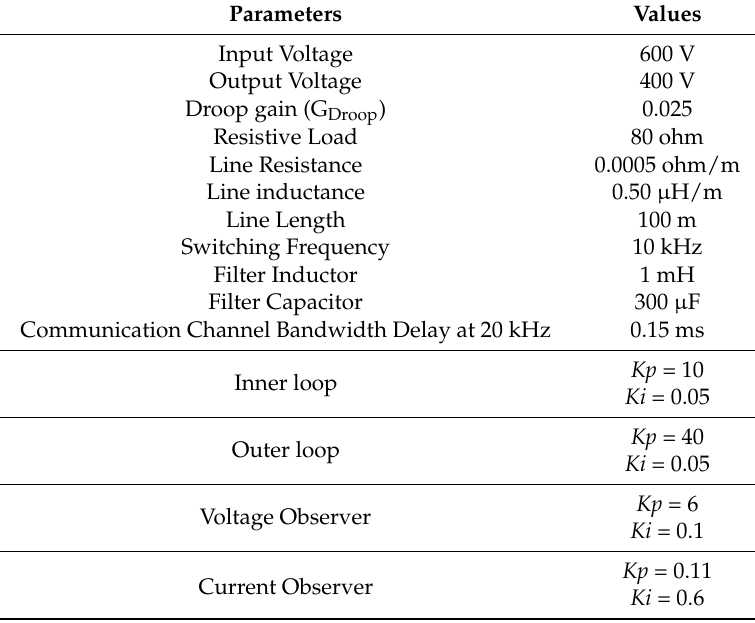
Table 1. Parameters for single converter node in DC microgrid.